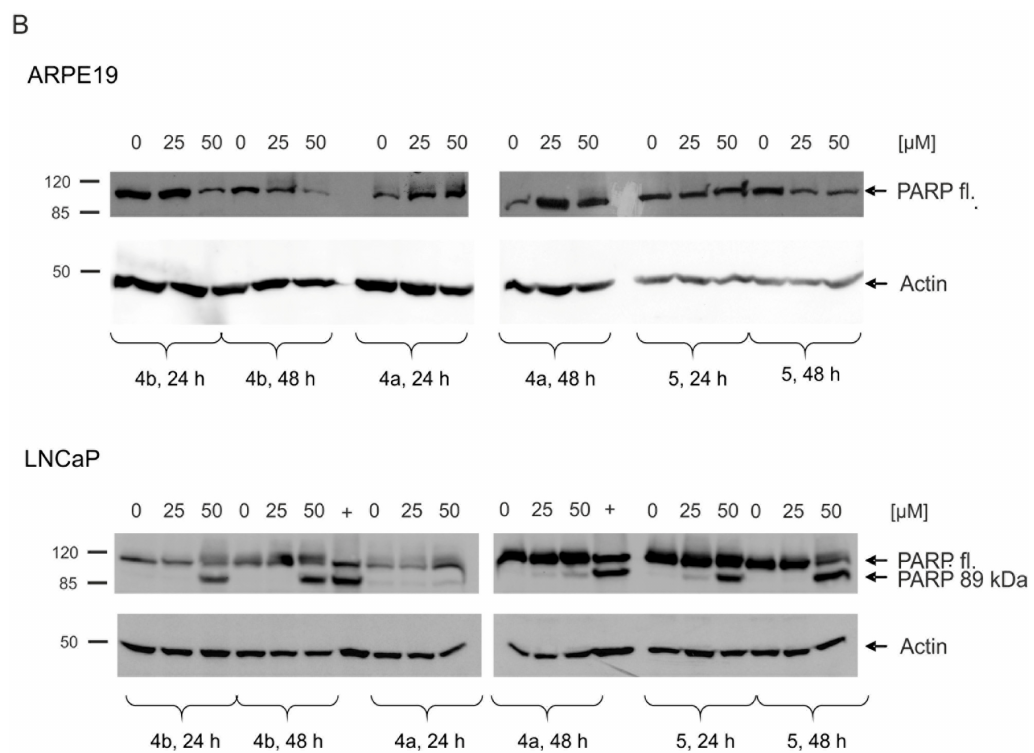
Figure 6. Induction of apoptosis in prostate cancer cell line LNCaP and non-neoplastic retinal pigment epithelial cell line ARPE19. ( A ) ARPE19 or LNCaP cells were treated with DMSO as control (0 µ M) or with 25 or 50 µ M 4b , 4a or 5 for 24 or 48 h. Activity of caspases 3 and 7 was determined using